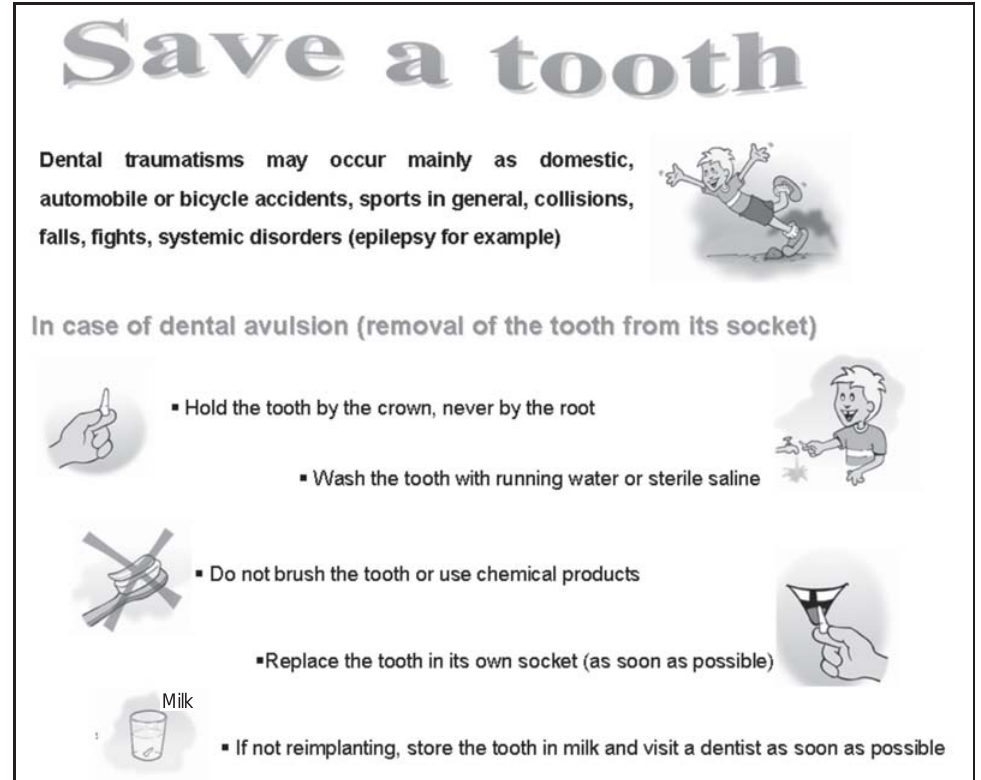
FIGURE 1- Copy of the folder distributed to school professionals in the city of Adamantina, São Paulo State, Brazil, as part of the informative campaign on tooth avulsion